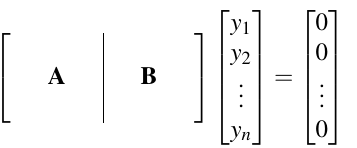
Fig. 2. Illustration of the dimensional matrix transformation via Gauss-Jordan elimination in which the same elementary row operations are applied to the entire